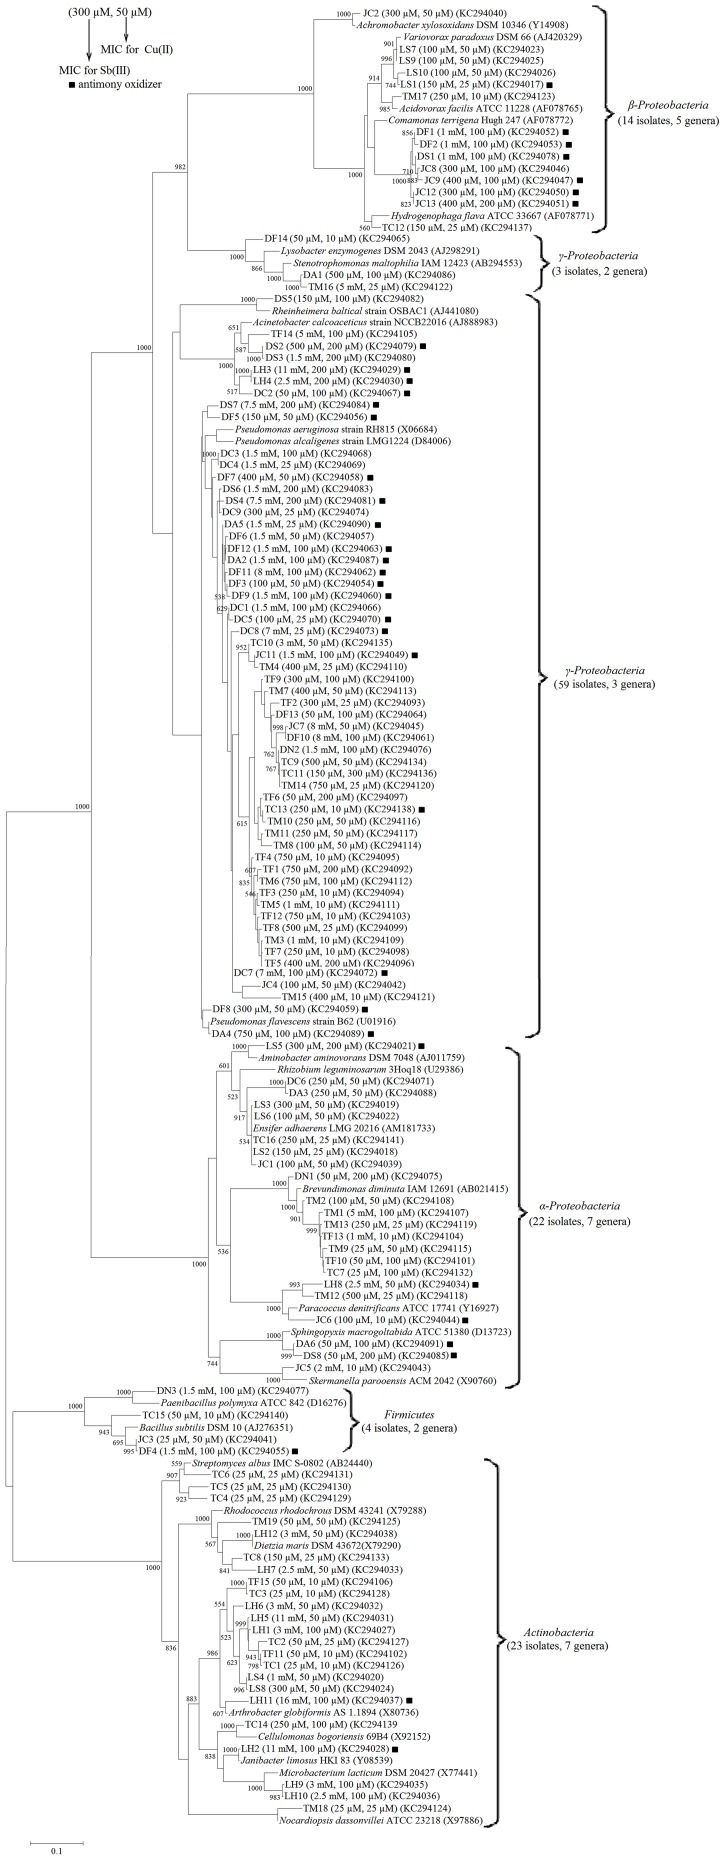
A maximum-likelihood phylogenetic tree on the basis of 16S rRNA gene sequences.The numbers at the nodes indicate bootstrap values (>500) based on 1000 replicates. Bar 0.1, 10 substitutions per 100 nucleotides. The Sb(III)/Cu(II)-resistant bacteria (including Sb(III)-oxidizing bacteria) were isolated using CDM medium as described in Material and Methods. ▪ represents the Sb(III)-oxidizing bacteria. The MIC values for Sb(III) and Cu(II), and the nucleotide accession numbers are shown after each strain's name.